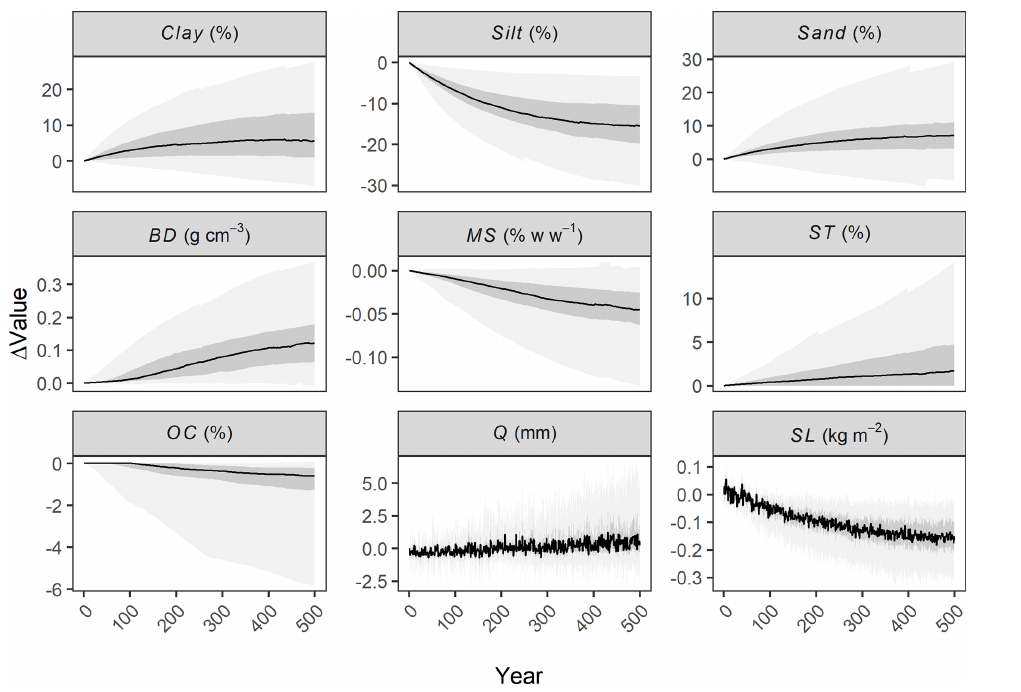
Figure 10. Annual changes in model parameter values and simulated runoff depths and soil losses over 500 years for the soil profiles from the UK SOILPITS database. The solid dark line represents the median of all profiles and simulations, whereas the shaded dark- and light-grey areas are 50% and 95% prediction intervals,